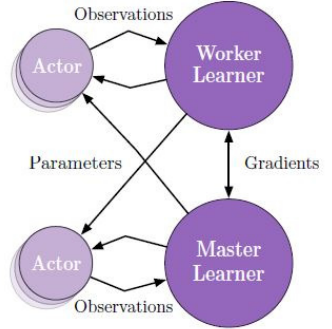
Figure 6. IMPALA multiple synchronous leaners model.